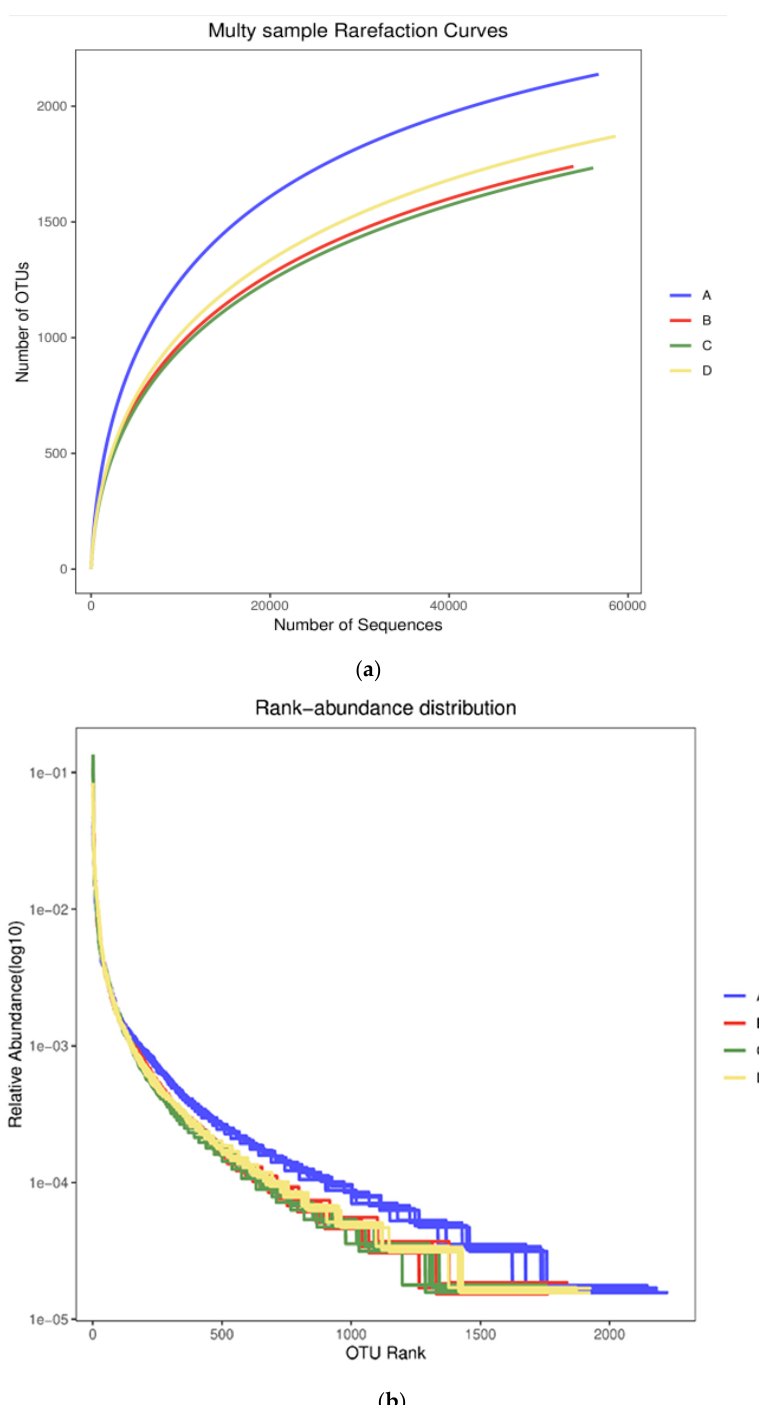
Figure 2. Diversity of bacterial communities in activated sludge samples: ( a ) rarefaction curves and ( b ) rank abundance curves. Note: A: inlet; B: aerobic zone; C: anoxic zone; D: anaerobic zone. Table 2. Richness and diversity indices of microbial communities for sludge samples.